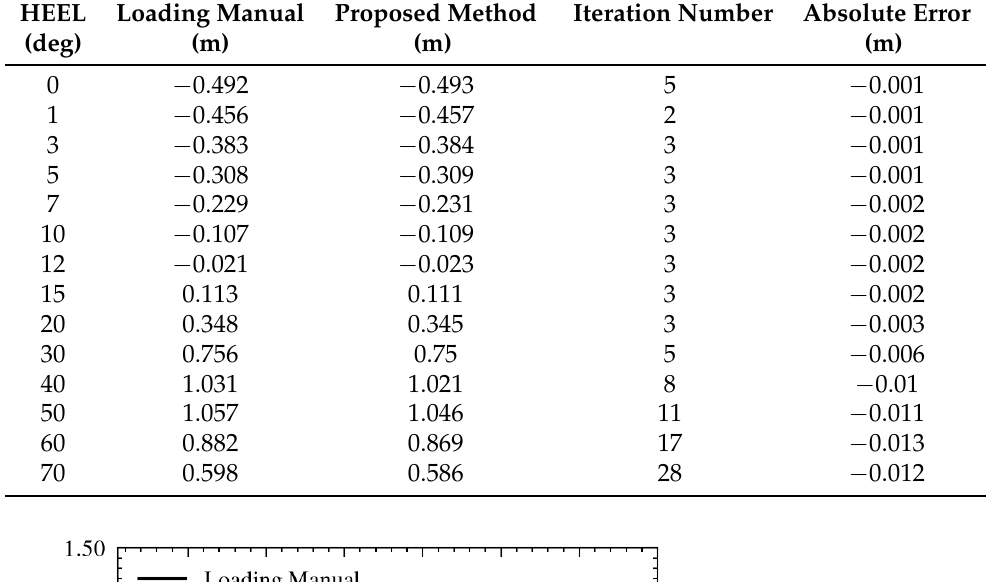
Table 13. GZ calculation result of INI15-DAM10.